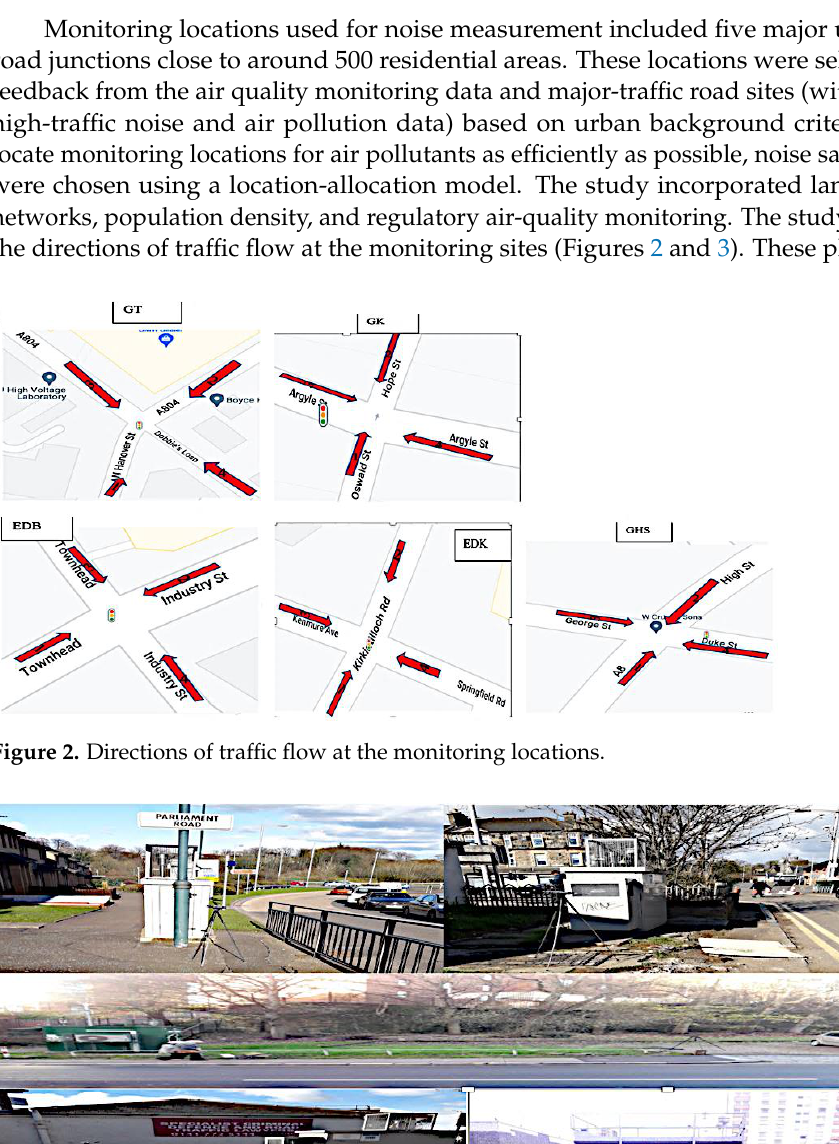
Figure 1. Map of study area. The maps were created using the QGIS 3.24.3-Tisler software (Open Source Geospatial Foundation Project, Chicago, USA).